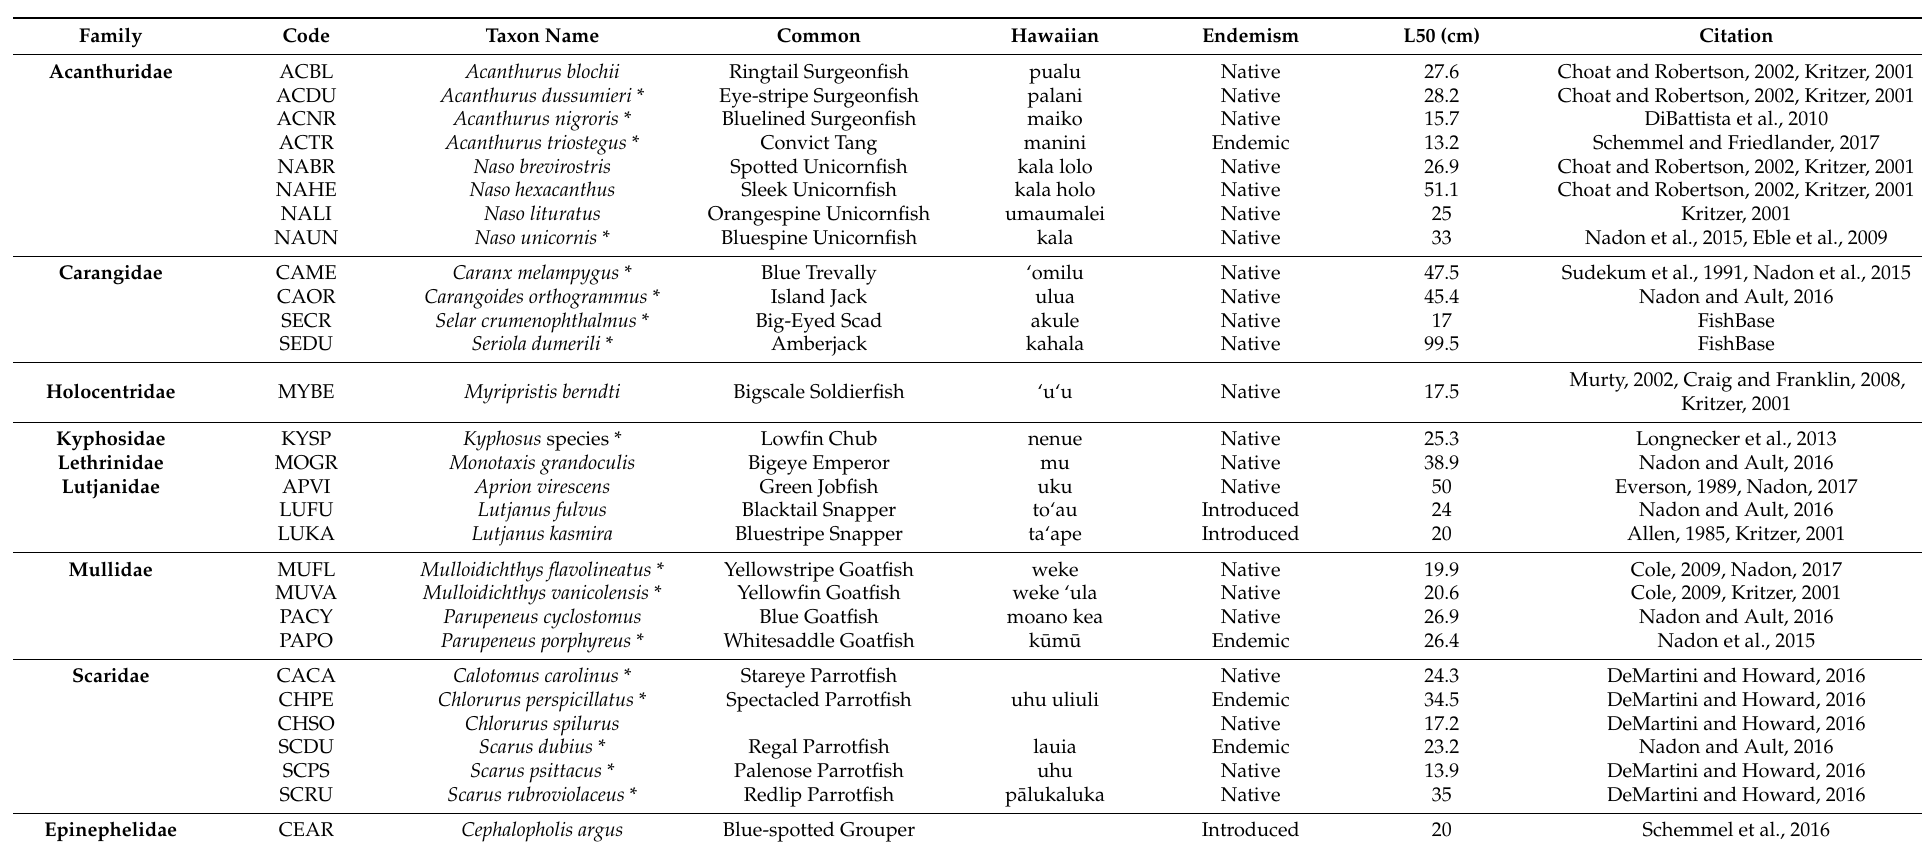
Table A1. List of resource fish species with sources from which L 50 values were derived. Species derived from the H¯a‘ena resource fish species list are noted with an asterisk (*) [13–27,32,33].